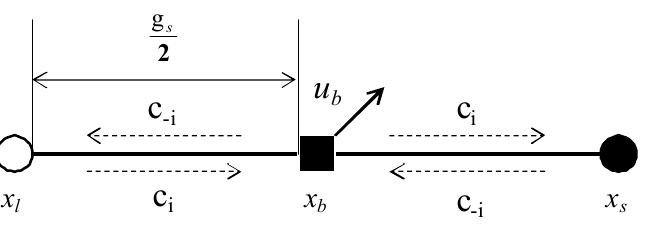
Figure 1. Sketch map of half step rebound format.